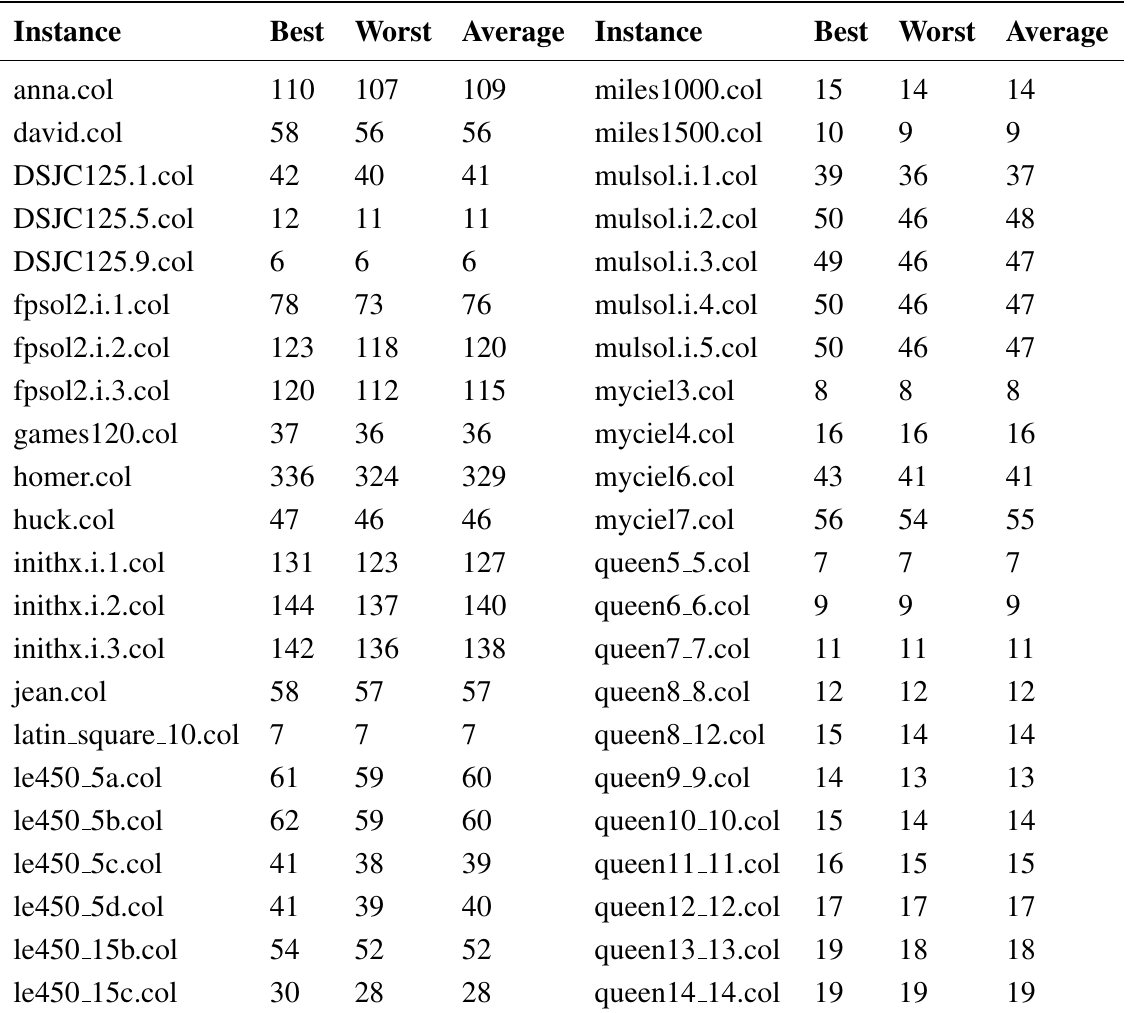
= 2 and a CPU-time limit of 30 min for 15 max